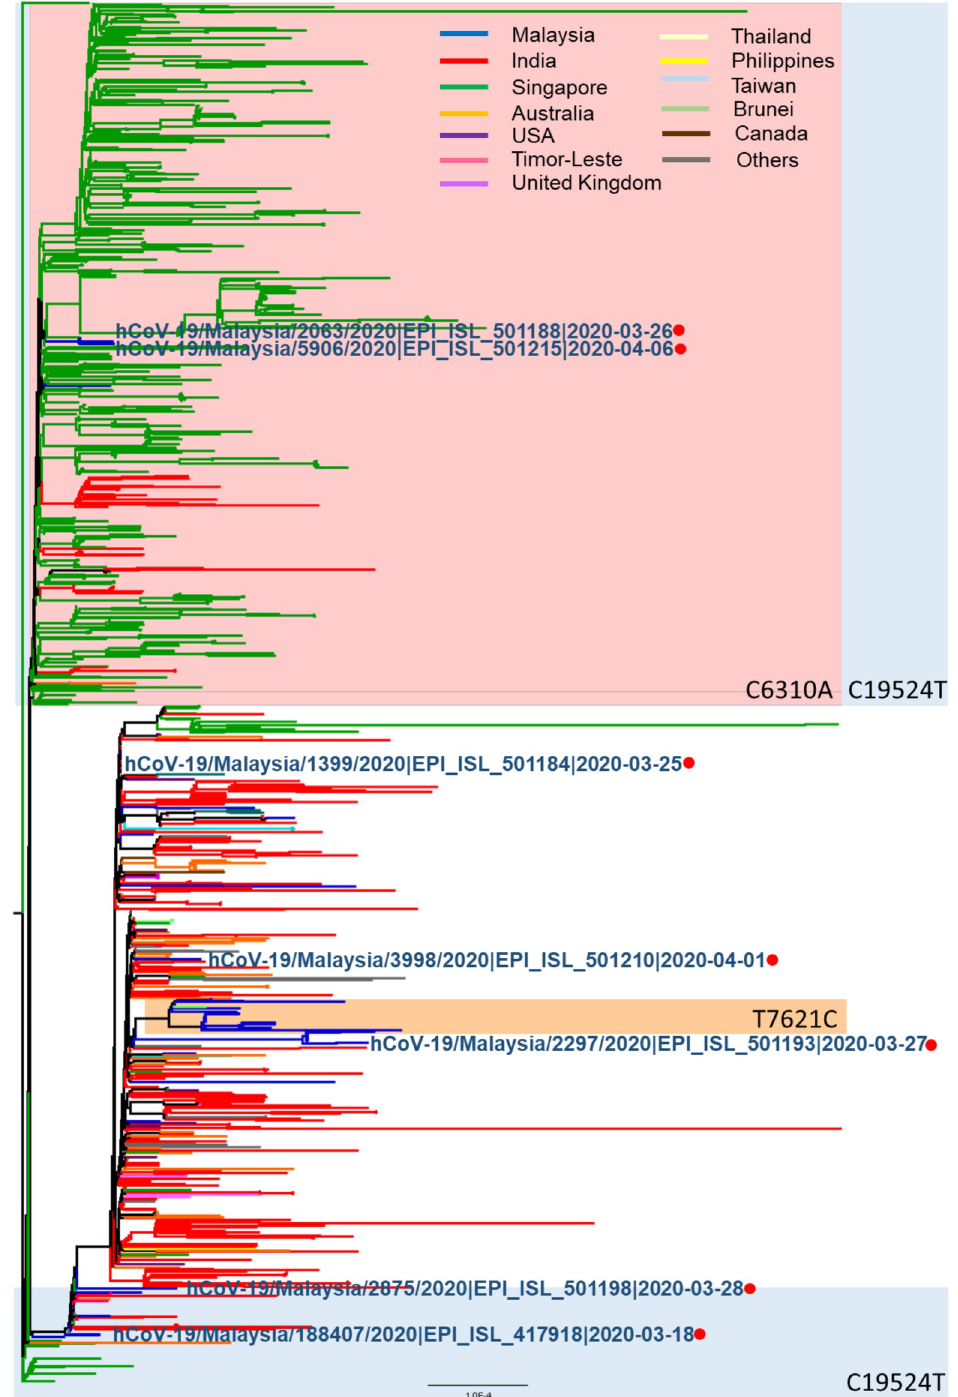
Fig 3. Phylogenetic tree of 1,122 high-quality B.6 lineage SARS-CoV-2 sequences with > 29,000 bp, < 1% Ns and < 0.05% unique amino acid mutations available from the GISAID database as of 20 September 2020. Sequences linked to the Tablighi Jamaat gathering are labelled in blue and denoted with red